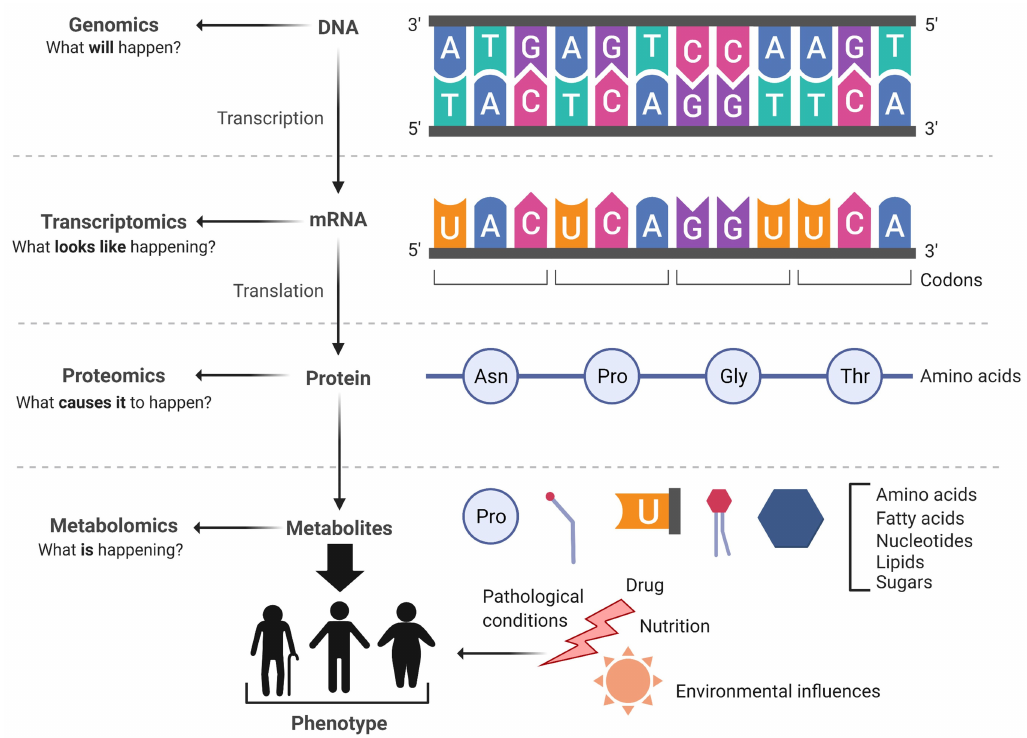
Figure 2. The ‘omics cascade’. It depicts the directional flow of biological information from genes to metabolites. Metabolomics is at the end of the cascade and is closer to the phenotype of an organism than proteomics or